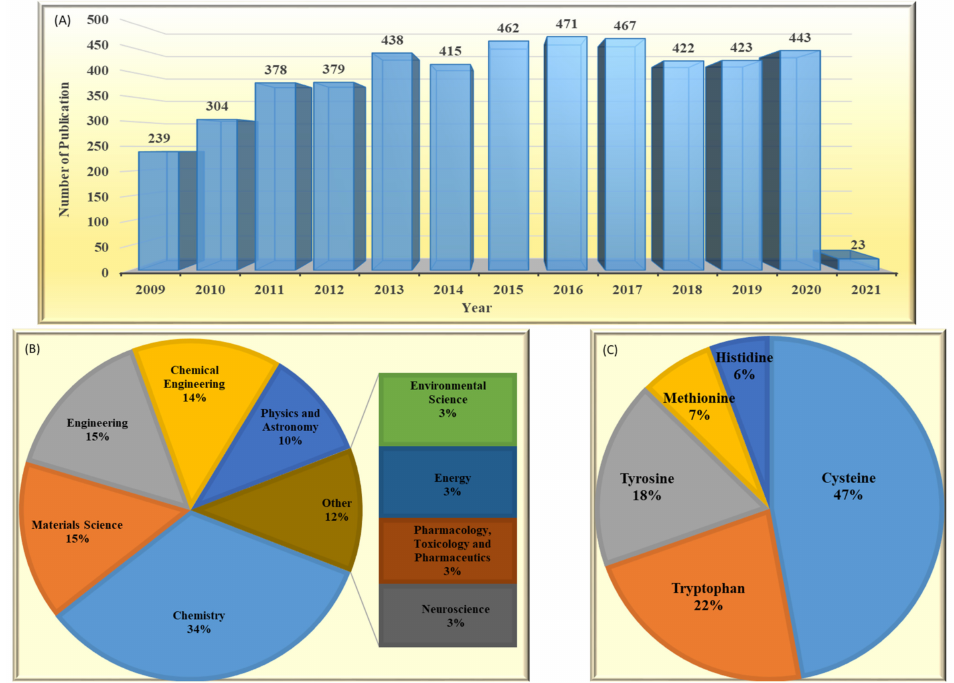
Figure 2. A comparative demonstration of ( A ) published papers per year searching ‘amino acid’ and ‘electrode’. ( B ) Categorized published papers in the first 10 scientific areas according to number of papers. ( C ) Published papers for 5 well-known electroactive amino acids searching the ‘name of the amino acid’ and ‘electrode’ and ‘detection’. All results refer to a search in the Scopus database (9 January 2021) by limiting the search to the title, abstract and keywords (Title, Abs and